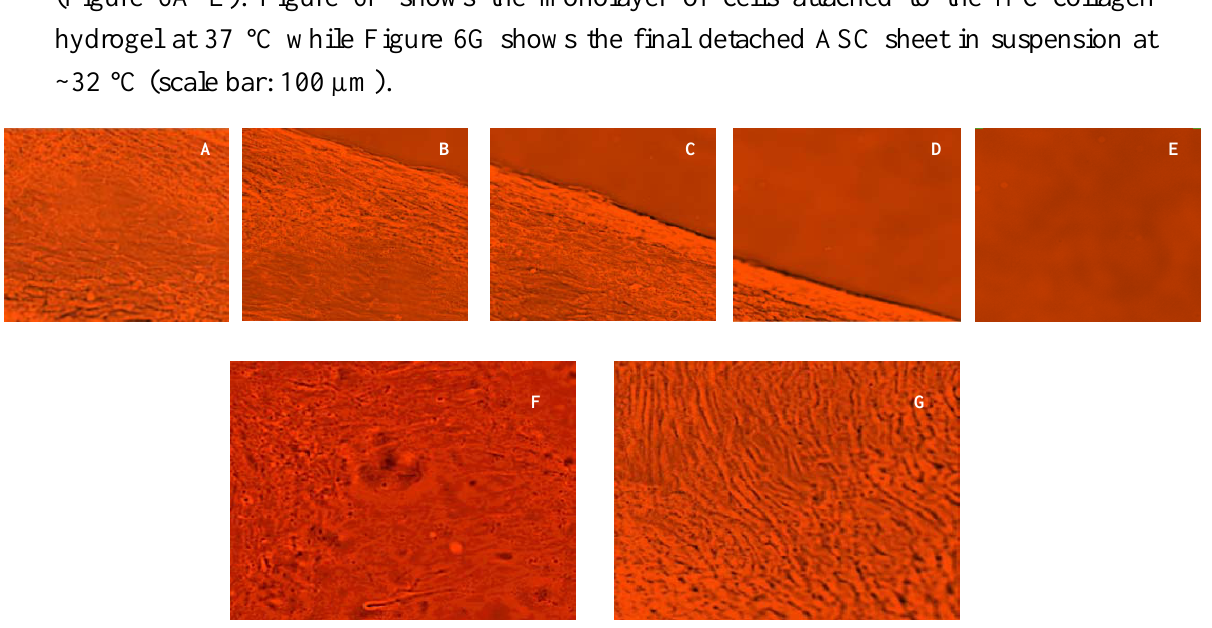
Figure 6. A series of bright-field microscopic images of the detaching ASC cell sheet with time (magnification 20×). The cell sheet detaches instantaneously (~1 min) after it was exposed to room temperature (~30 °C) and removed from the incubator (~37